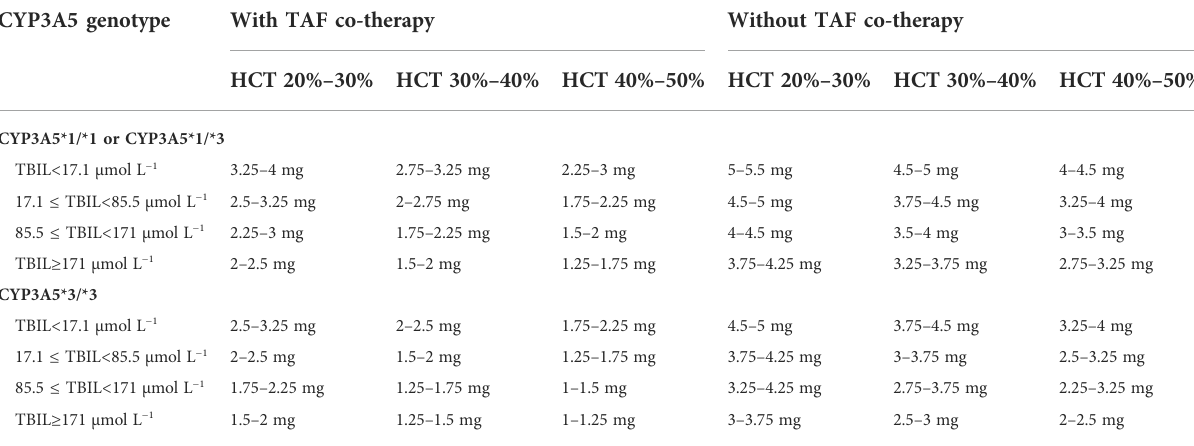
TABLE 6 MM model-informed individualized initial dose regimens based on